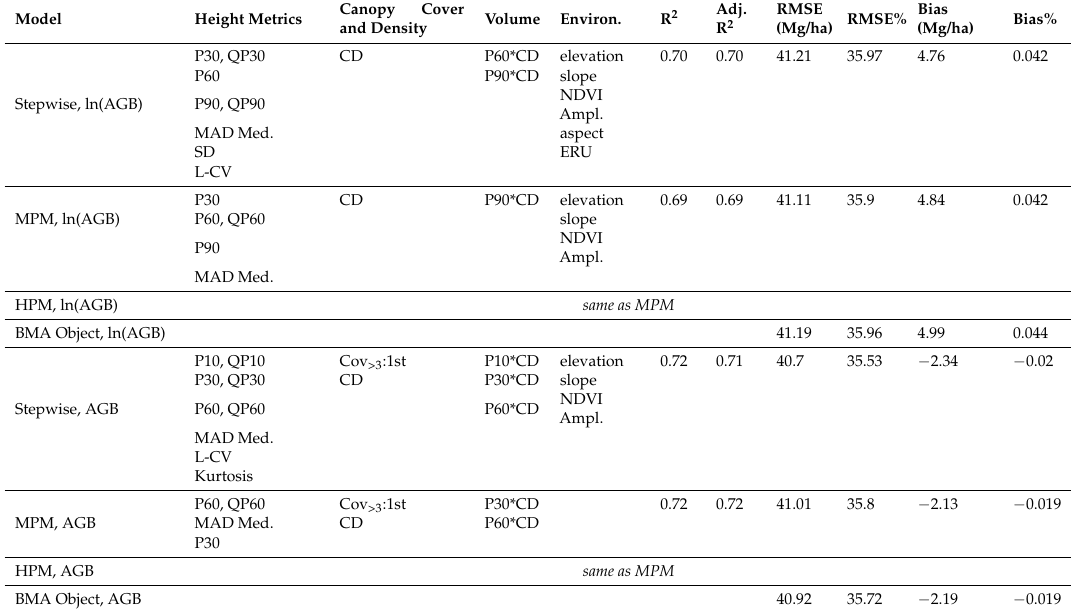
Table 5. Model summary statistics of the estimates of the multiple linear models resulting from four model selection procedures– stepwise regression, median probability model (MPM) identified from Bayesian model averaging (BMA), the highest probability model (HPM) identified from BMA, and from the BMA ensemble object– each fit to a response variable, AGB, with no transform and with a log transform. R 2 and adjusted R 2 were calculated on the model calibration data. Root mean square error (RMSE), percent RMSE, bias and percent bias were all calculated on the validation data (the records withheld from model construction, not the transfer validation data